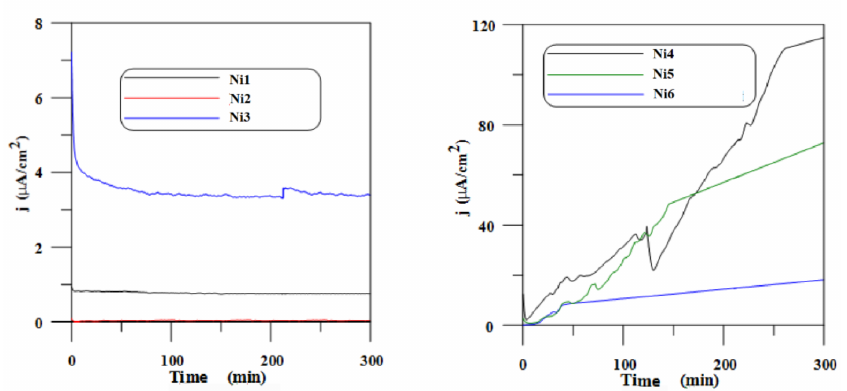
Figure 1. Potentiostatic polarization curves for specimens Ni1, Ni2, Ni3, Ni4, Ni5, and Ni6 in Ringer solution at a potential of 100 mV/ESC.